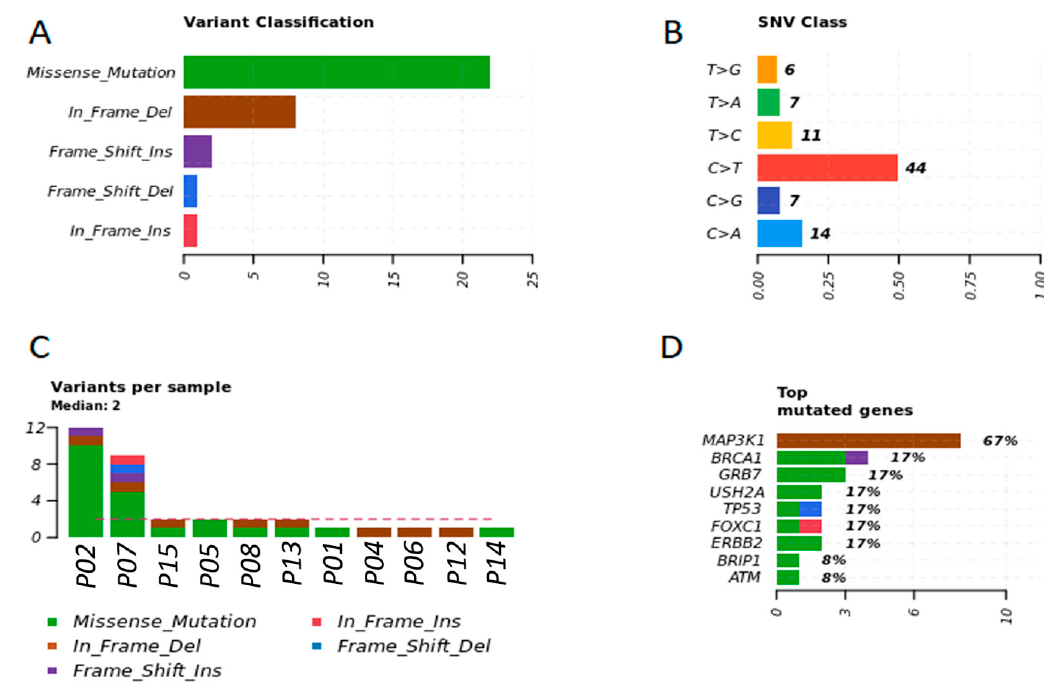
Figure 3. Genetic variation in plasma samples of women with BC. ( A ) Representative variant classification. ( B ) Single-nucleotide variant (SNV) classification. ( C ) Representative variants per plasma sample. ( D ) Top mutated genes showing multiple variant mutations. Graphics were generated in the R language, using the Maftools package.